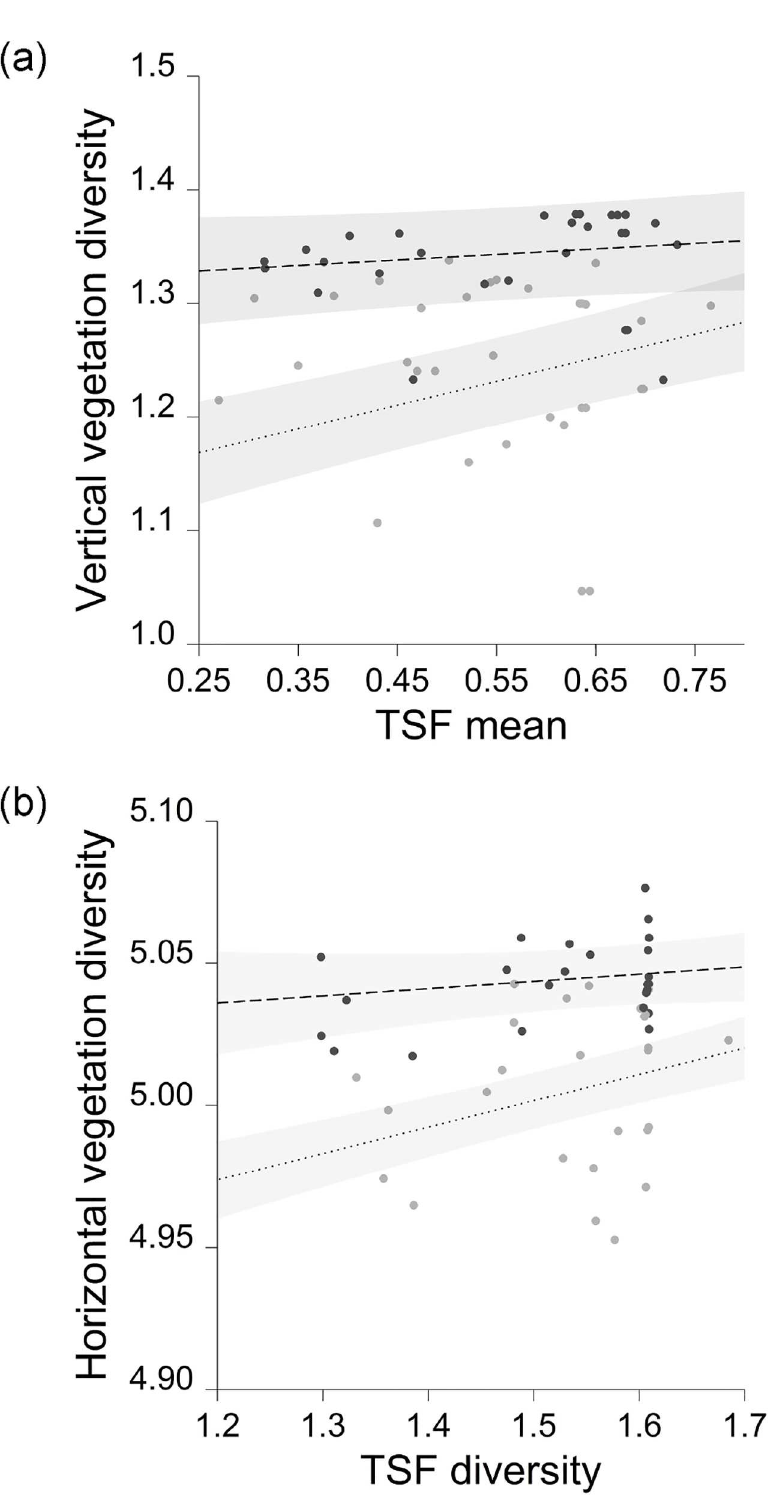
Fig 4. Responses of vertical and horizontal diversity to the mean and diversity of the time since fire index (TSF). Predictions and 95% confidence intervals are derivedfrom top-rankedlinear mixed models. Point colours and line types correspondto different vegetation types (dry forest = grey points, dotted lines; wet forest = black points, dashed